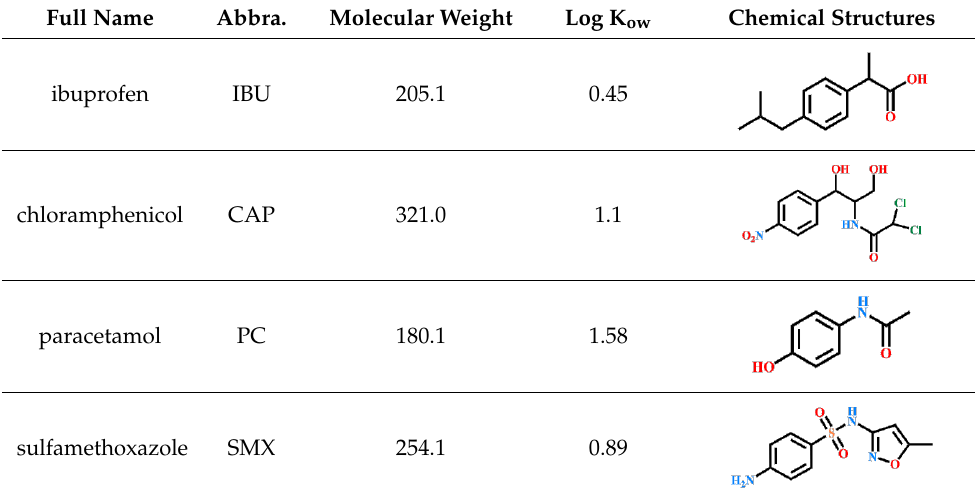
Table 1. Pharmaceuticals used in this study.